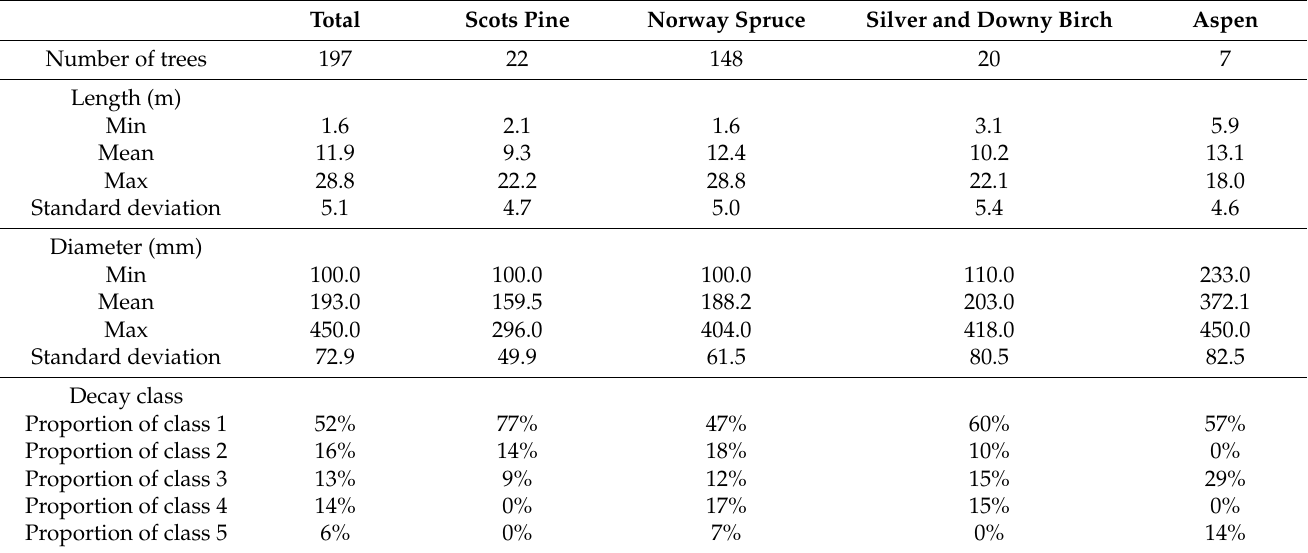
Table 1. Summary statistics of the reference trees, including the minimum (min), mean, maxi- mum (max), and standard deviation for length and diameter, and the proportion of trees in each decay class. Total Scots Pine Norway Spruce Silver and Downy Birch Aspen